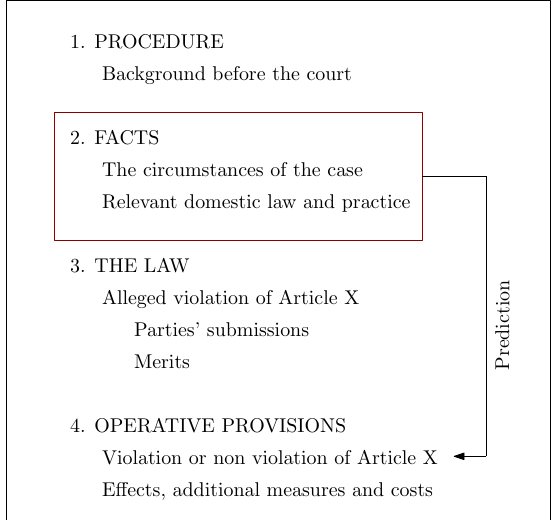
Figure 1. Structure of a court